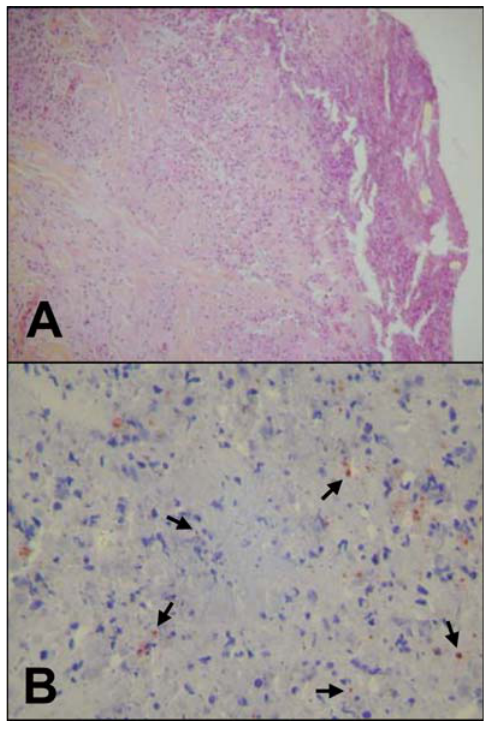
Figure 1. Inoculation eschar from a patient with MSF. (A) Histologic examination of inoculation eschar from a patient with MSF showing numerous dermal inflammatory infiltrates mainly composed of polymorphonuclear leukocytes with large necrotic areas and coagula- tive necrosis of the epidermis (hematoxylin-eosin-saffron, original magnification 6 100). (B) Immunohistochemical detection of R. conorii in the inoculation eschar. Anti- R. conorii antibodies were detected using biotinylated secondary antibody, followed by avidin-peroxidase color development. The bacteria thus stained in reddish/brown, and indicated by the arrows, appear located between the necrotic inflammatory cells present in the dermis (original magnification 6 400).